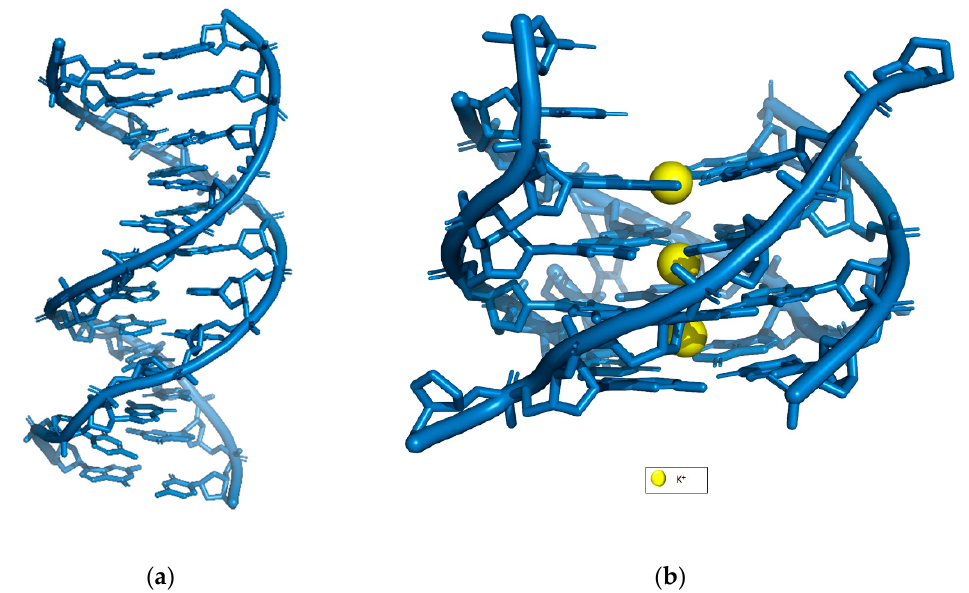
Figure 1. Comparison of ( a ) DNA double helix (PDB: 1BNA) and ( b ) DNA G-quadruplex stabilized by K + (PDB: 244D).